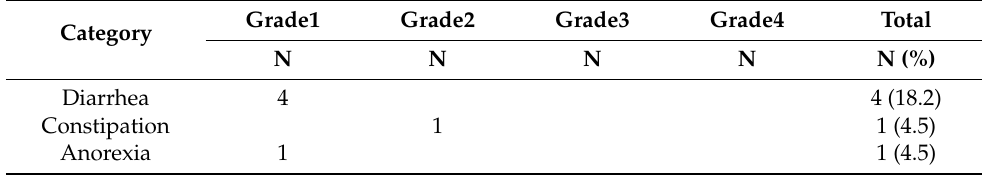
Table 5. Safety profiles of Brazilian green